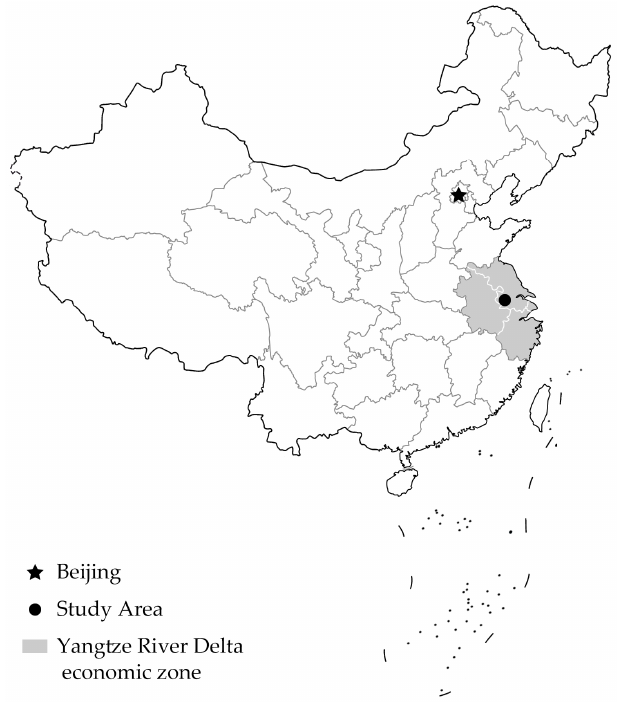
Figure 1. Study area.